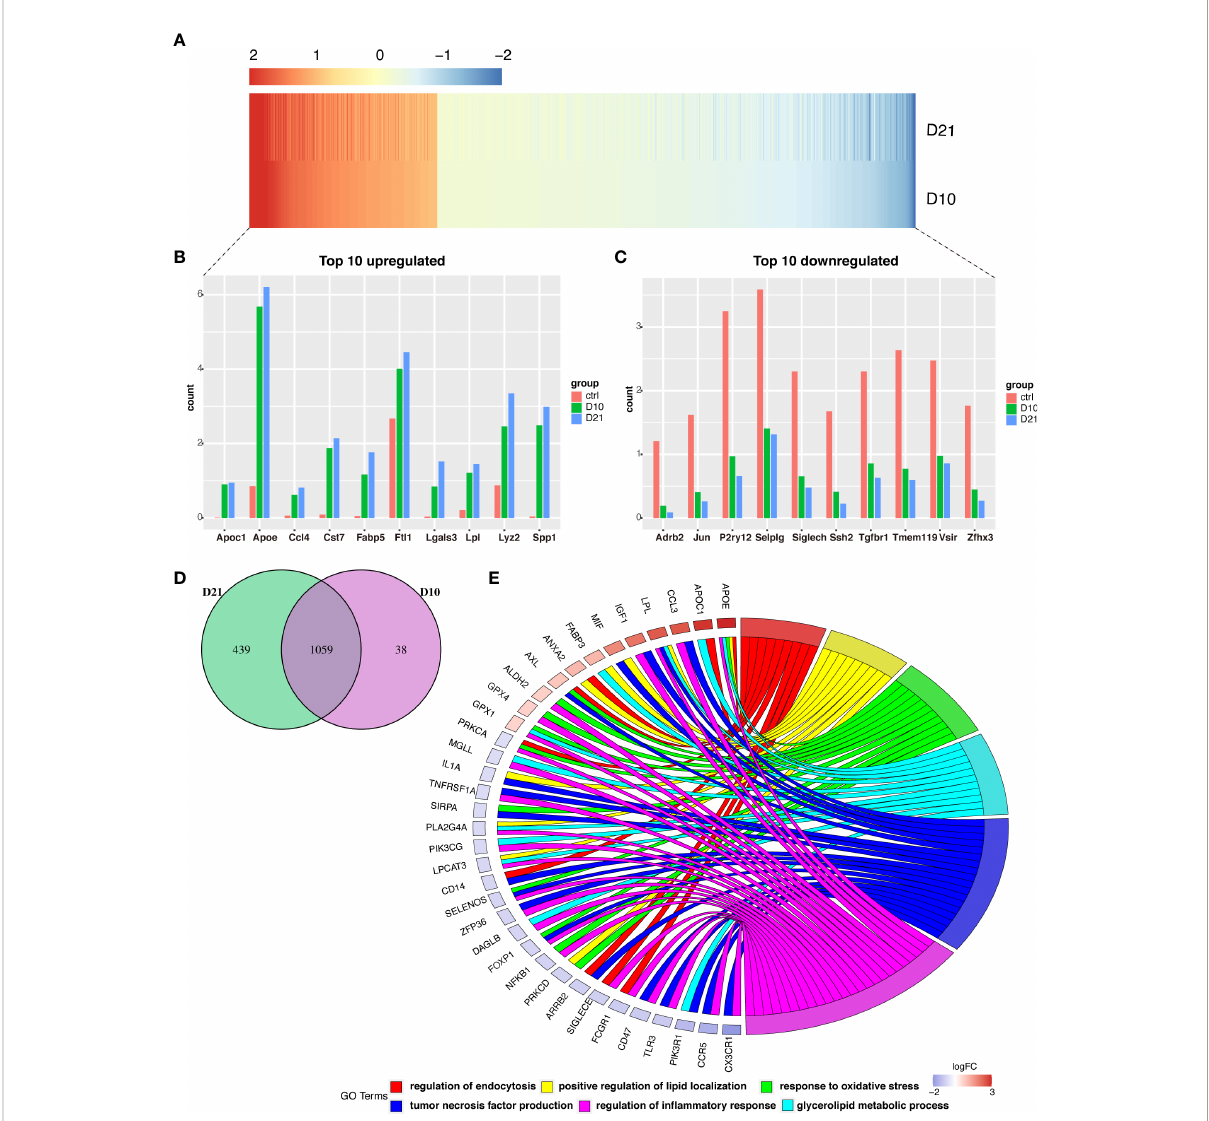
FIGURE 4 Analysis of differential gene expression in microglia following spinal cord injury (SCI). (A) Heatmap showing differentially expressed genes (DEGs) in microglia sampled 10- and 21-days post injury (dpi) compared with those sampled from the sham group. (B, C) Bar graph showing the top 10 upregulated and downregulated genes in microglia sampled 10 dpi and 21 dpi. (D) Venn diagram showing overlap between DEGs in microglia sampled 10 dpi and 21 dpi. (E) Chord plot showing the gene ontology (GO) of biological processes associated with overlapping DEGs in microglia sampled 10 dpi and 21